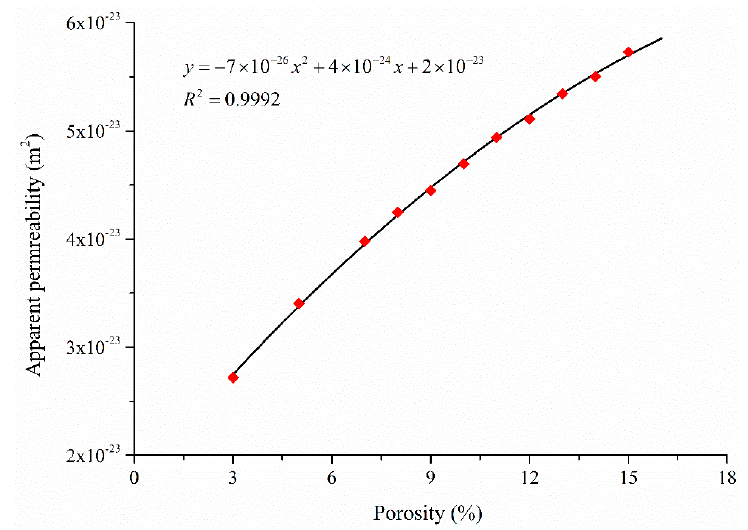
Figure 8. Variation of the apparent gas permeability with porosity.